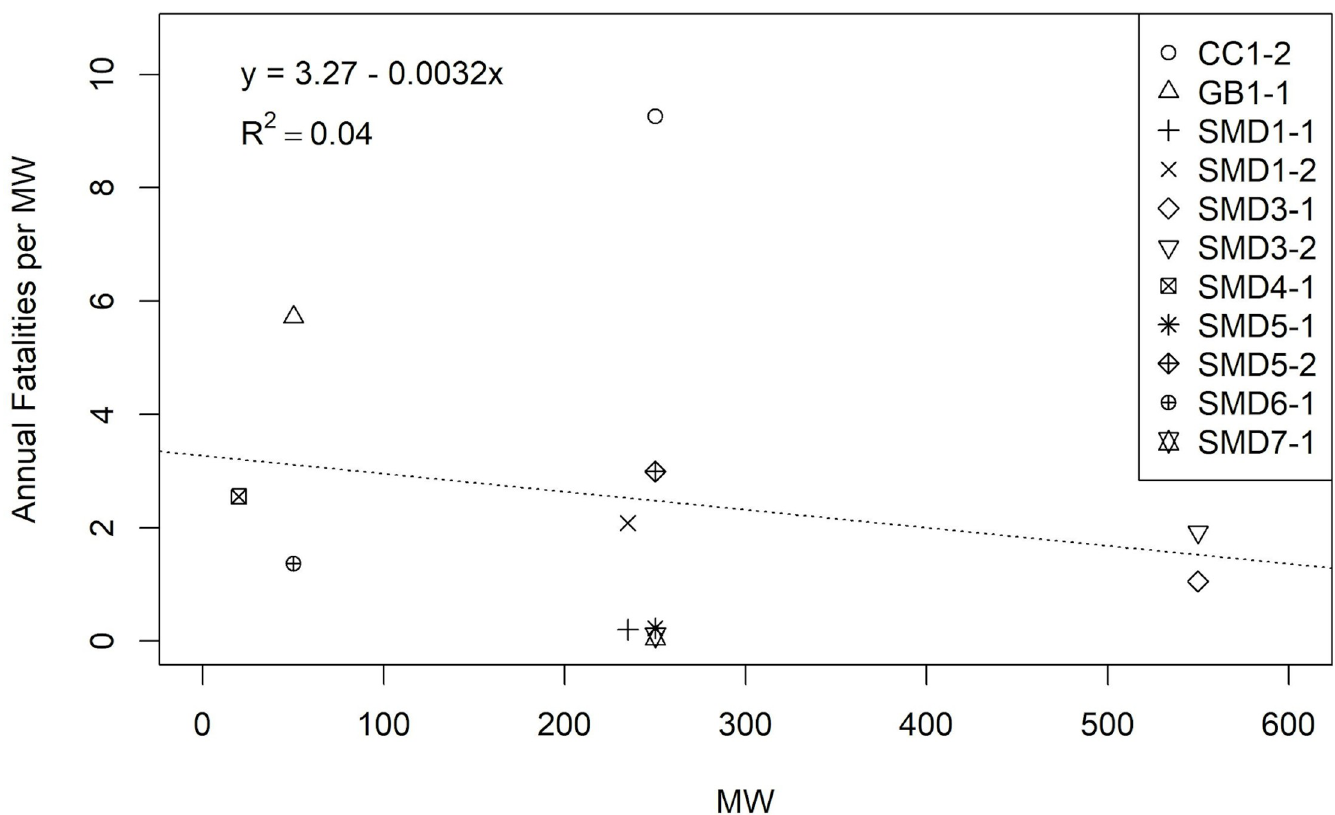
Fig 5. Annual all bird fatality estimates, adjusted for detection probability and search effort, per megawatt (MW; nameplate capacity), by nameplate capacity, from January 1, 2013, to September 1, 2018.